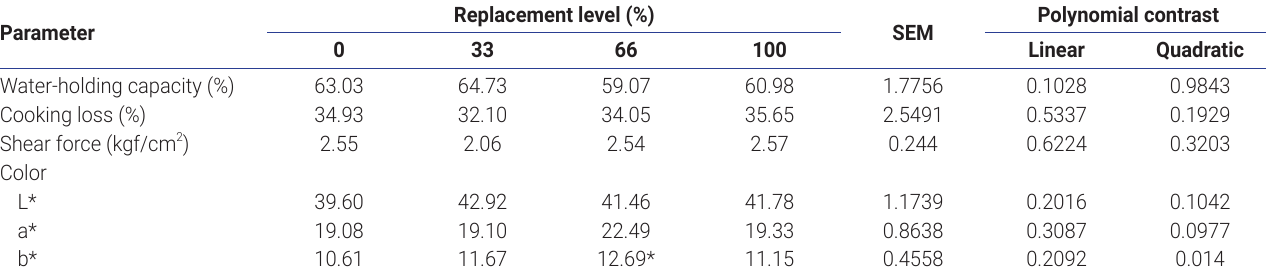
Table 4. Physical traits of the meat from buffaloes fed sugarcane-based diets supplemented with spineless cactus replacing wheat bran Replacement level Parameter